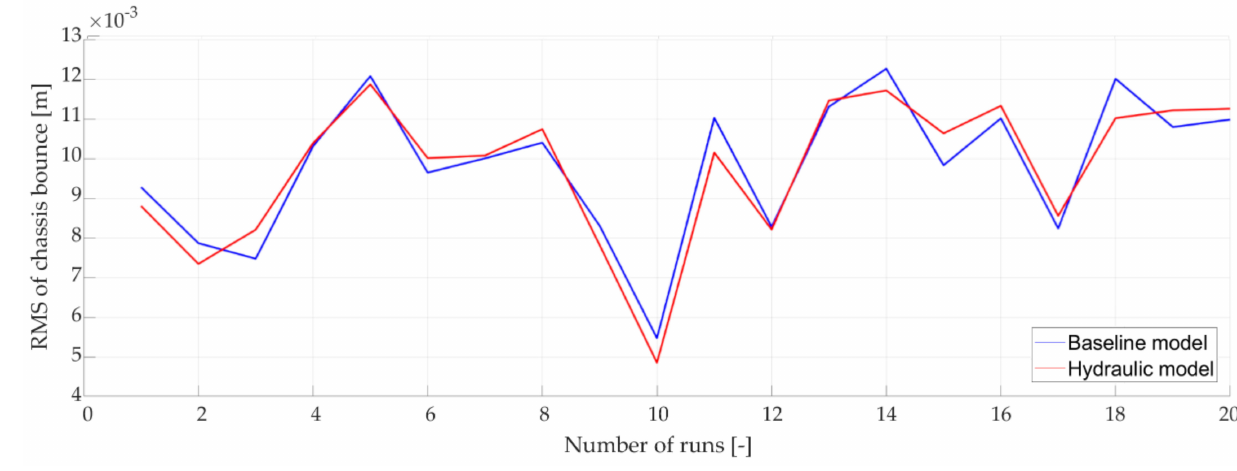
Figure 16. Chassis bounce root mean square for a realistic road profile.